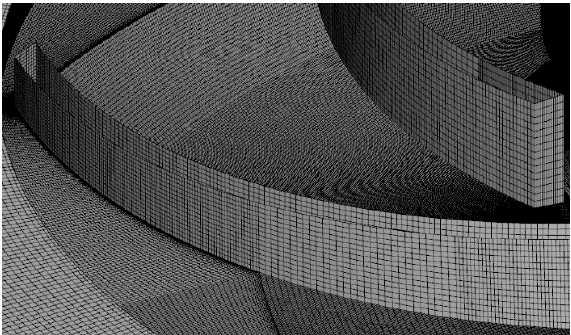
Table 1. Geometric specifications of the centrifugal impeller.